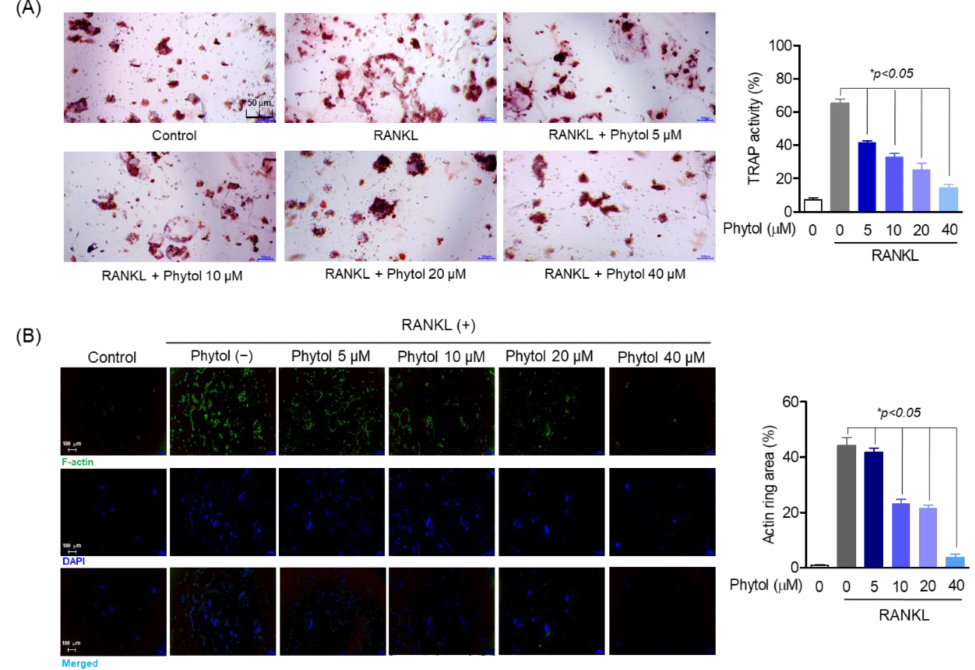
Figure 3. Inhibitory effect of phytol on receptor activator of nuclear factor kappa-B ligand (RANKL)- induced osteoclast differentiation and formation. ( A ) The cells (1 × 10 3 cells/well) were seeded in 24-well plates and incubated for 24 h. After treatment with phytol at different concentration with or without 50 ng/mL RANKL for 5 days, TRAP staining and activity was carried out. ( B ) To investigate osteoclast formation, the cells were stimulated with RANKL and treated with phytol for 5 days. Alexa 488-Phalloidin (green) and DAPI (blue) was used to stain the actin cytoskeleton and counterstain the nuclei, respectively. Data are presented as the mean of three independent experiments (Mean ± SD). * p < 0.05, compared to the RANKL-induced